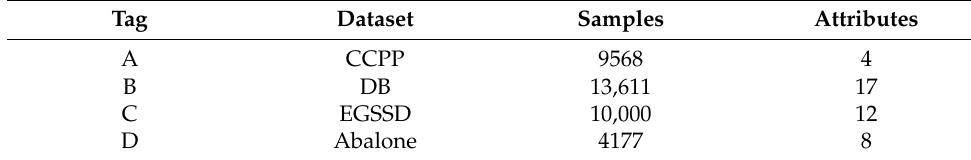
Table 8. Benchmark datasets